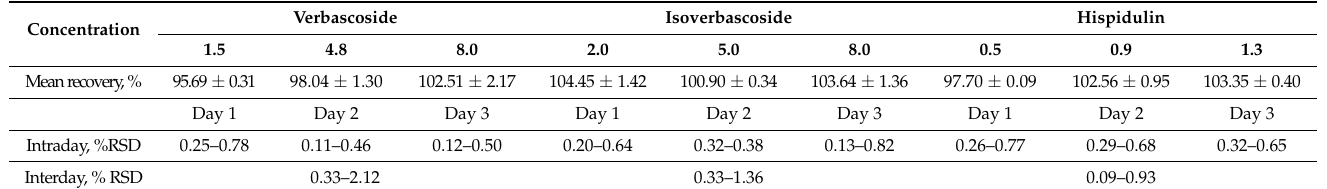
Table 3. Accuracy and precision of the proposed HPLC method. Data are shown as the mean ± SD ( n =